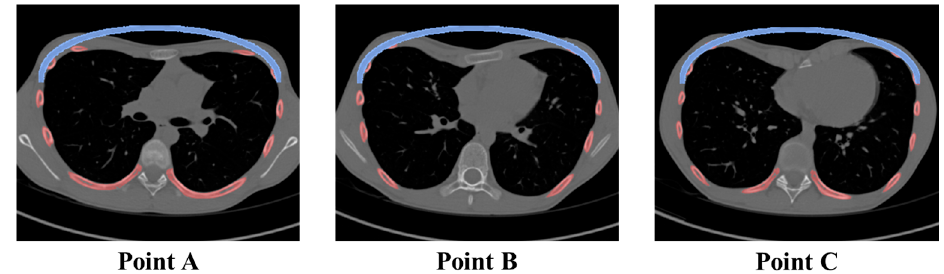
Figure 5. Illustrations of corrected sternum after Nuss bar insertion. The same shape of the Nuss bar was located on the CT axial image with insertion points.